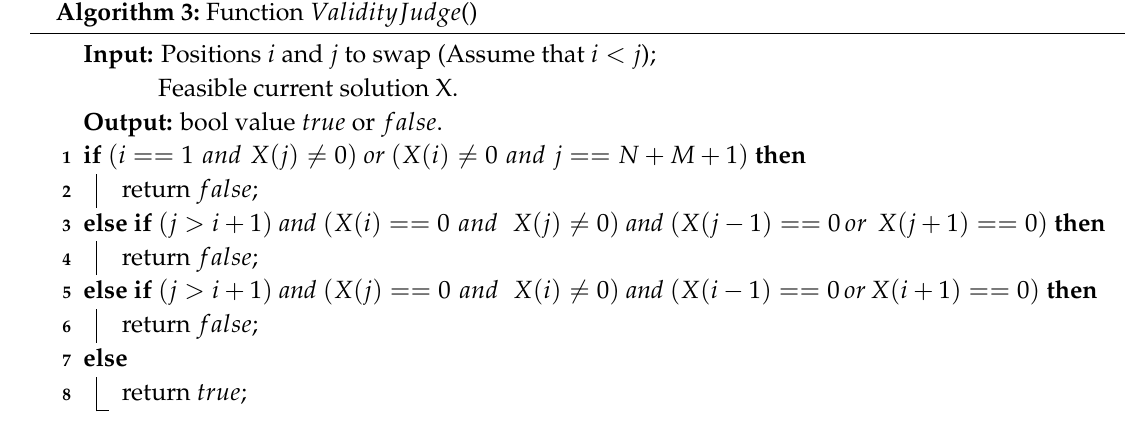
Figure 5. An example of effective swaps and invalid swaps. Algorithm 3: Function ValidityJudge ()